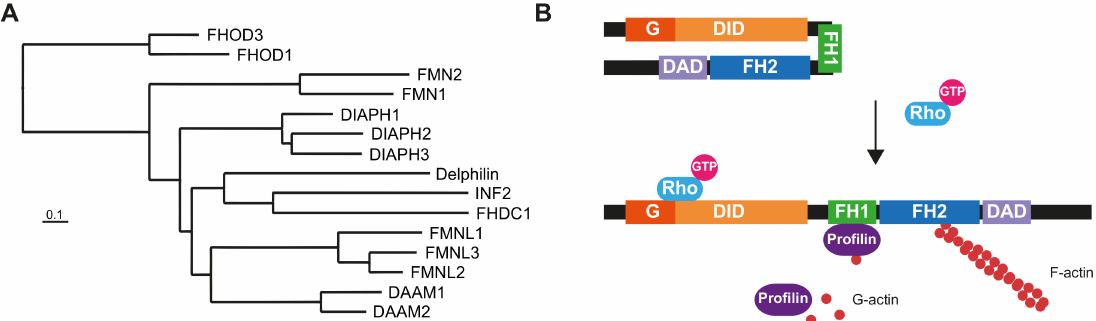
Figure 1. The human formin family. ( A ) Tree of human formins. The FH2 domain sequence of the formins was aligned with BLAST and the alignment was used to construct the tree [103]. The UniProt accession numbers of the corresponding sequences were: DIAPH1 (O60610), DIAPH2 (O60879), DIAPH3 (Q9NSV4), DAAM1 (Q9Y4D1), DAAM2 (Q86T65), FMNL1 (O95466), FMNL2 (Q96PY5), FMNL3 (Q8IVF7), FHOD1 (Q9Y613), FHOD3 (Q2V2M9), FMN1 (Q68DA7), FMN2 (Q9NZ56), INF2 (Q27J81), FHDC1 (Q9C0D6) and Delphilin (A4D2P6). ( B ) Structure and regulation of Diaphanous-related formins. The interaction of the DID and the DAD maintains the formin in a closed, inactive conformation. The binding of a specific GTP-loaded Rho GTPase to the N-terminal region of the formin opens the molecule, rendering it in its active form. The FH1 domain recruits profilin, which feeds the FH2 domain with G-actin to form the actin filaments. The illustrated molecules are not drawn to